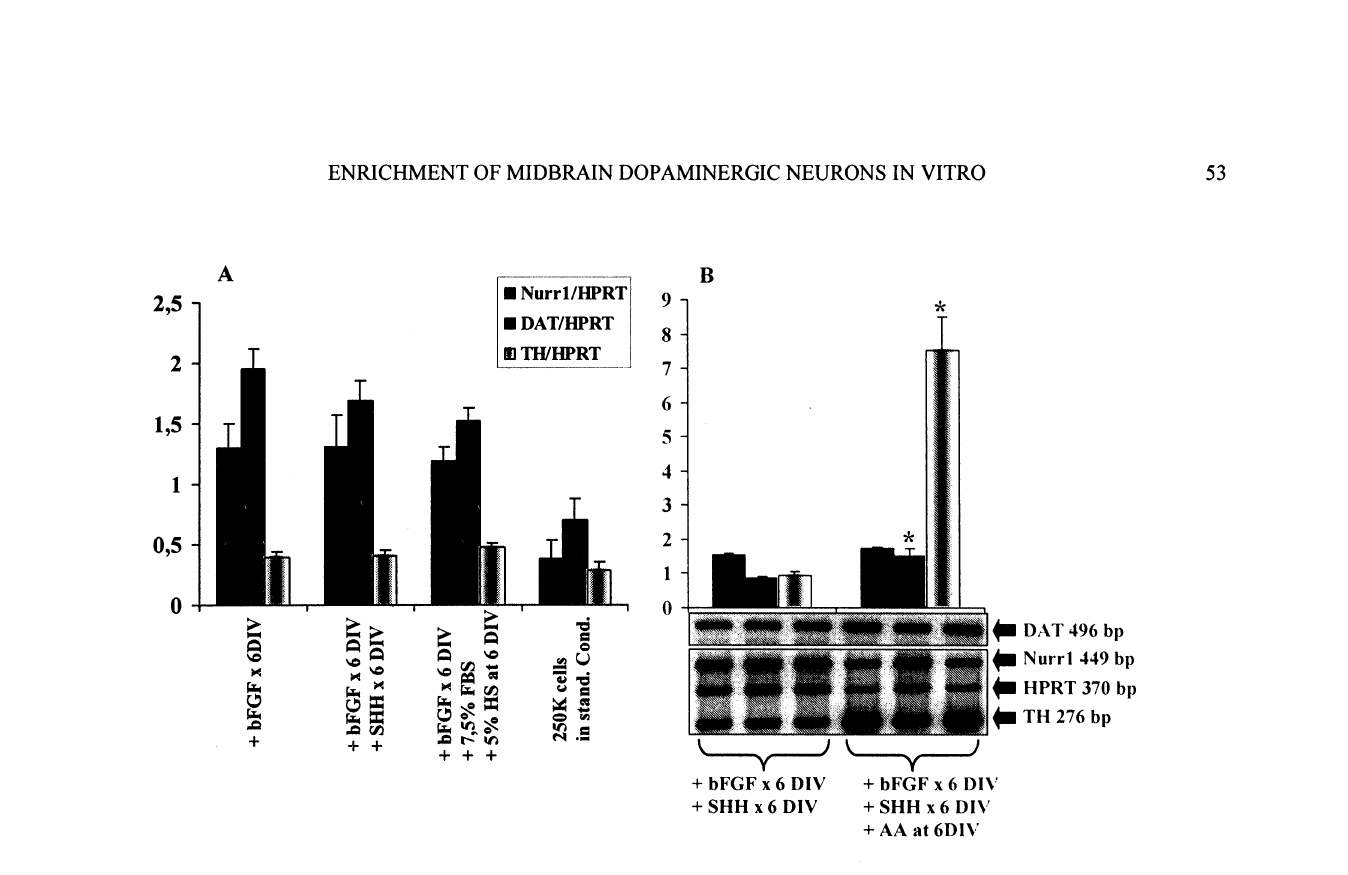
Fig. 4" Dopaminergic gene expression in expanded and standard mesencephalic cultures. The diagrams show the relative quantization (mean +/- SEM) ofNurrl, dopamine transporter (DAT) and tyrosine hydroxylase (TH) amplified product, assessed by RT-PCR, compared to that of the hypoxanthine phosphoribosyl transferase (HPRT, internal standard). Data are expressed as ratio Nurrl/HPRT, DAT/HPRT, TH/HPRT. (A): Expanded MES cultures were analyzed at 12 DIV after the treatment with bFGF for 6 DIV, or bFGF and SHH for the first 6 DIV, or bFGF for the first 6 DIV and consequently addition offetal bovine serum (FBS) and horse serum (HS), or plated in standard conditions (see Experimental section). (B): Expanded MES cultures were analyzed at 9 DIV after treatment with bFGF and SHH for the first 6 DIV and subsequent administration of ascorbic acid (AA) for three more days. The gel in the inset shows triplicate samples for each experimental condition of the co-amplified DAT, Nurrl, HPRT, and TH fragments. The size of the amplified products is shown on the right in base pairs (bp). Asterisks represent p<0.01 when compared to cultures without AA (ANOVA, Scheff6 F-